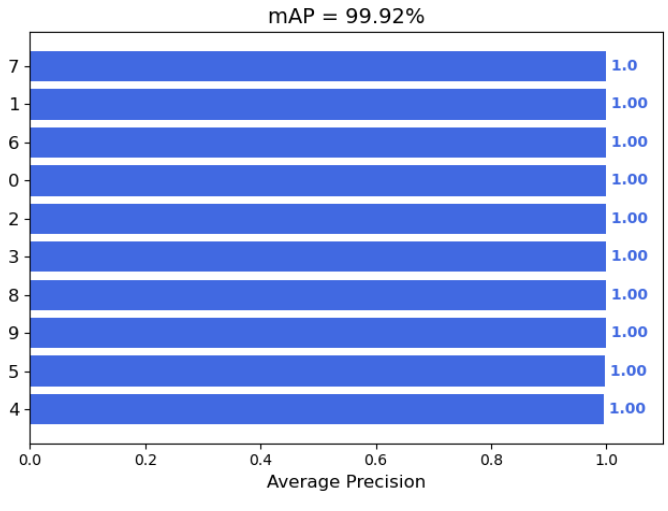
Figure 13. Average accuracy of 10 types of digital regions.